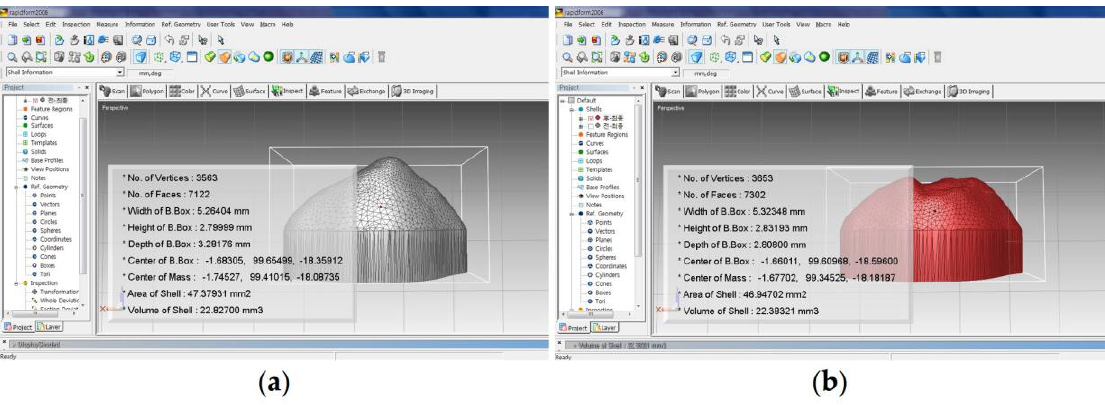
Figure 3. Volume measurements using a three-dimensional (3D) scanned image. ( a ) Before wear; ( b ) after wear.